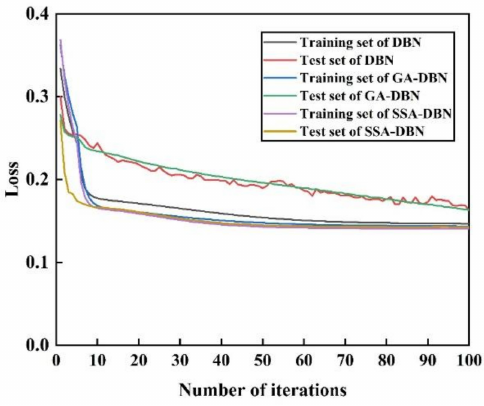
Figure 12. Comparison of the results of loss